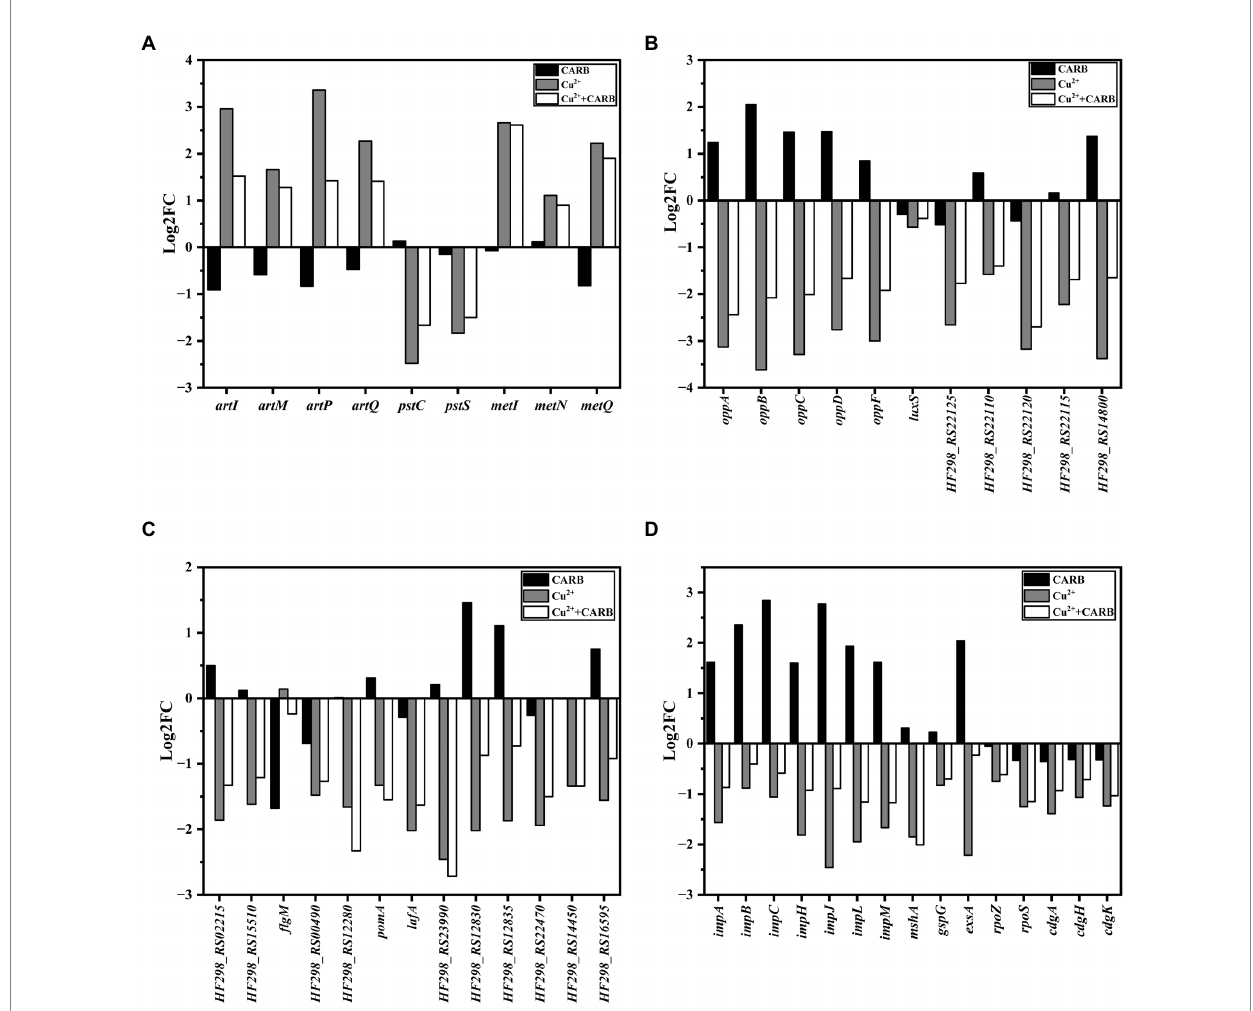
FIGURE 9 Differently expressed genes in biofilm related parts. (A) ABC transporters. (B) Quorum sensing systems. (C) Two-component systems. (D)